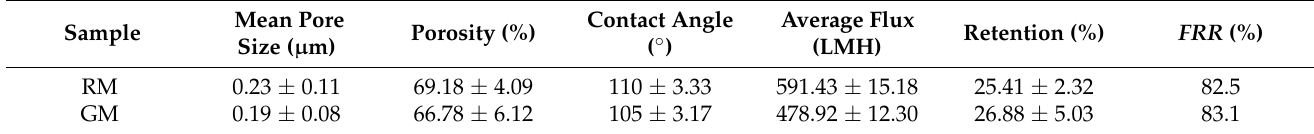
Figure 7. SEM micrograph at different magnifications for resin membrane (( a ) cross-section at low magnification, ( b ) plain surface, ( c ) statistical data of pore size distribution and ( d ) cross-section from top to bottom at high magnification) and gel membrane (( e ) cross-section at low magnification, ( f ) plain surface, ( g ) statistical data of pore size distribution and ( h ) cross-section from top to bottom at high magnification). Table 3. Membrane properties and performance analysis. Table 3. Membrane properties and performance analysis.